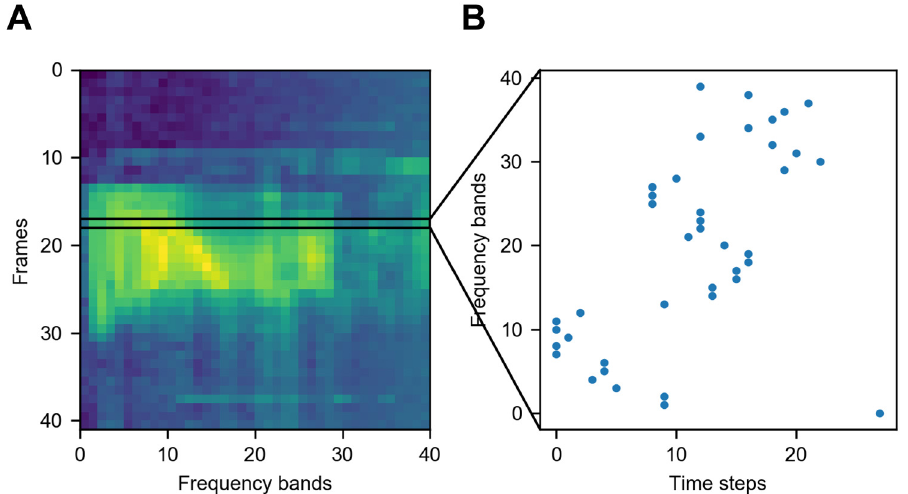
Fig 2. The input coding of the SNN. (A) The MFSC spectrogram of the spoken digit “one”. The horizontal axis represents the index of frequency bands, and the vertical axis represents the time frames. (B) The spike coding of one frame (the row of pixels inside the black box) in Fig A. The MFSC features are encoded by the time-to-first-spike coding scheme. The higher the feature value, the earlier the neuron fires. Note that the time axis of Fig B is irrelevant to time axis of Fig